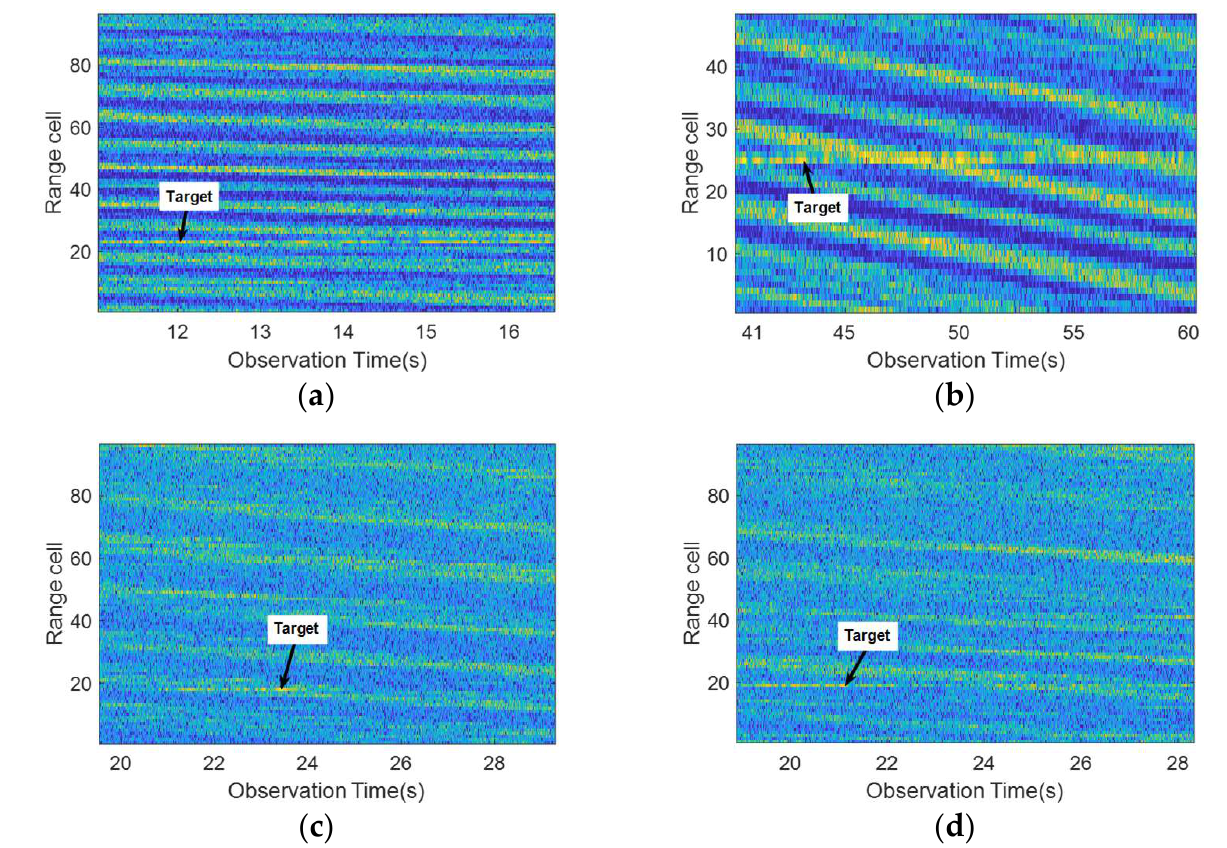
Figure 11. Radar echo intensity images of different marine floating targets. The images are obtained from the test samples, the radar observation targets are a floating fishing boat and a floating RIB from top to bottom by row, and the arrows point to the motion trajectory of the targets. ( a ) Data ID: #CSIR_01; ( b ) Data ID: #CSIR_02; ( c ) Data ID: #CSIR_03; and ( d ) Data ID: #CSIR_04.